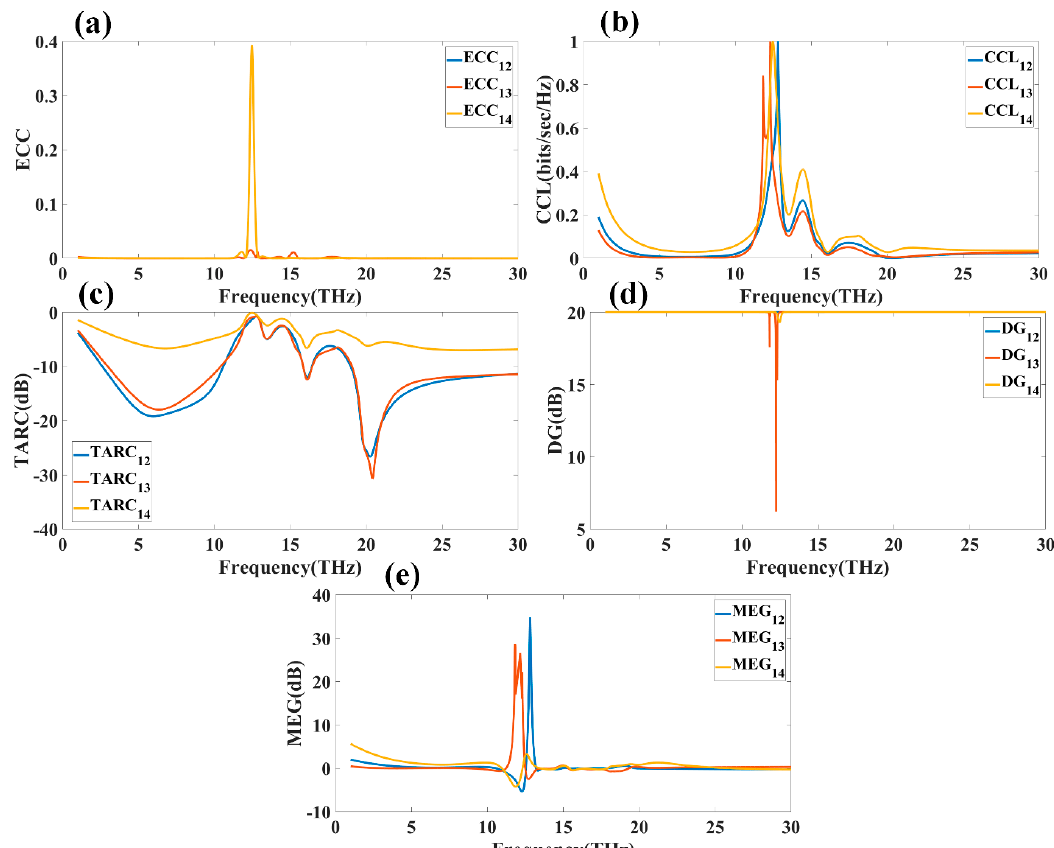
Figure 10. Different calculated parameters for the 2 × 2 MIMO antenna structure: ( a ) ECC, ( b ) CCL, ( c ) TARC, ( d ) DG, and ( e ) MEG. ( c ) TARC, ( d ) DG, and ( e )